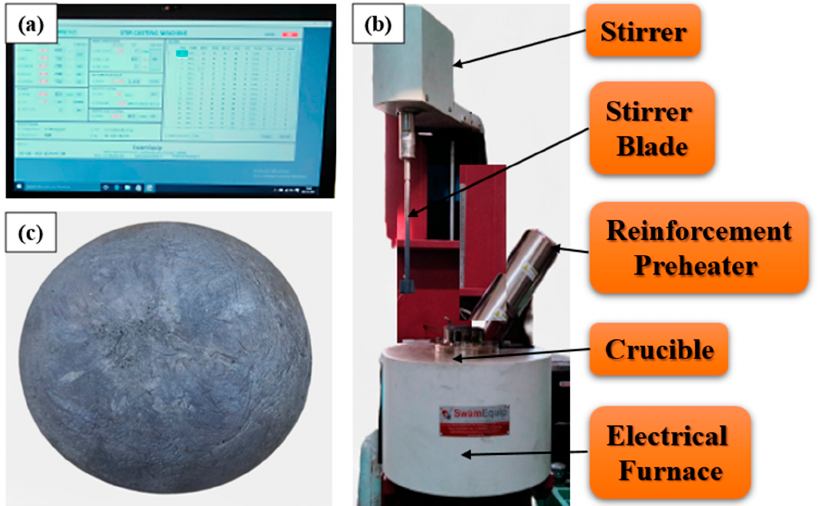
Figure 1. Schematic representation of the experimental arrangement for the stir casting process: ( a ) control section, ( b ) stir casting machine, and ( c ) prepared sample .